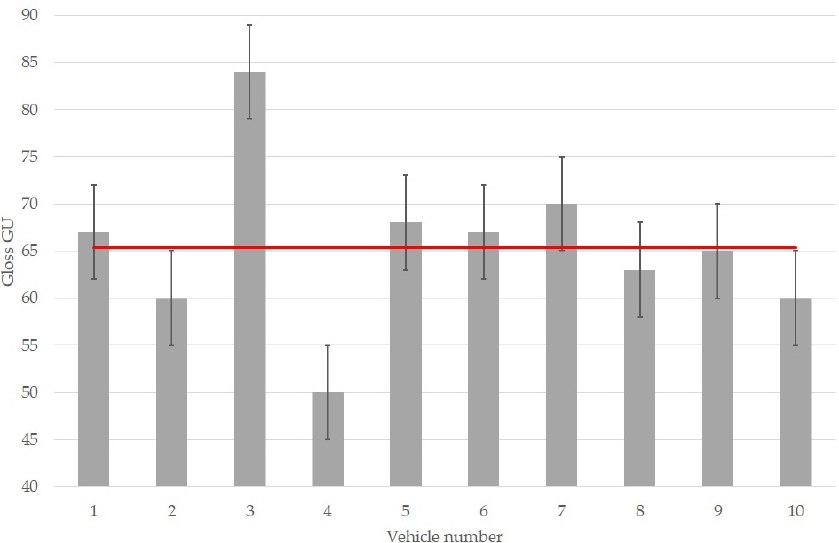
Figure 9. Average coating gloss values on the vehicle rear right fender for segment B vehicle (for all 10 vehicles), by the blue line, the mean value from 10 vehicles is added.